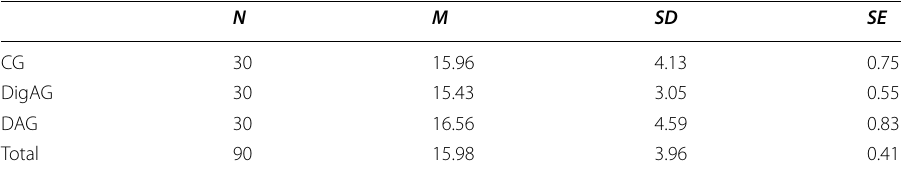
Table 11 Descriptive statistics of cognitive load pretest of all groups N M SD SE CG 30 15.96 DigAG